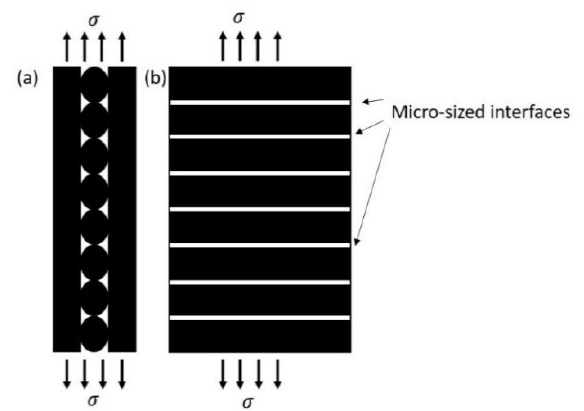
Figure 9. The schematic of transverse interfaces in [0, 90] samples: ( a ) edge view; ( b ) top view.